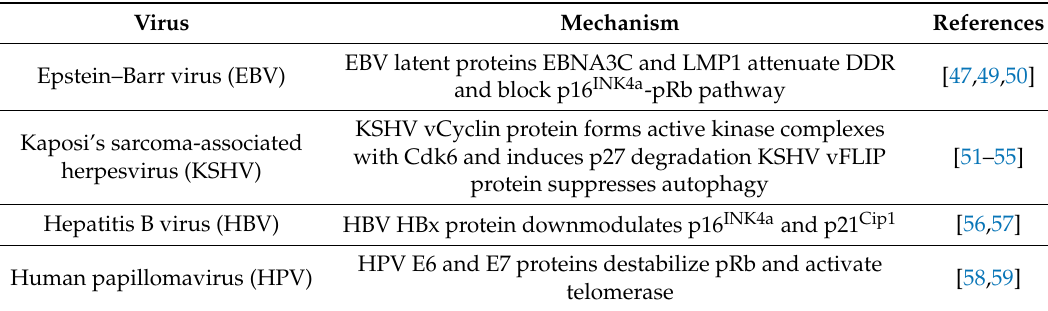
Table 2. Inhibition of senescence by